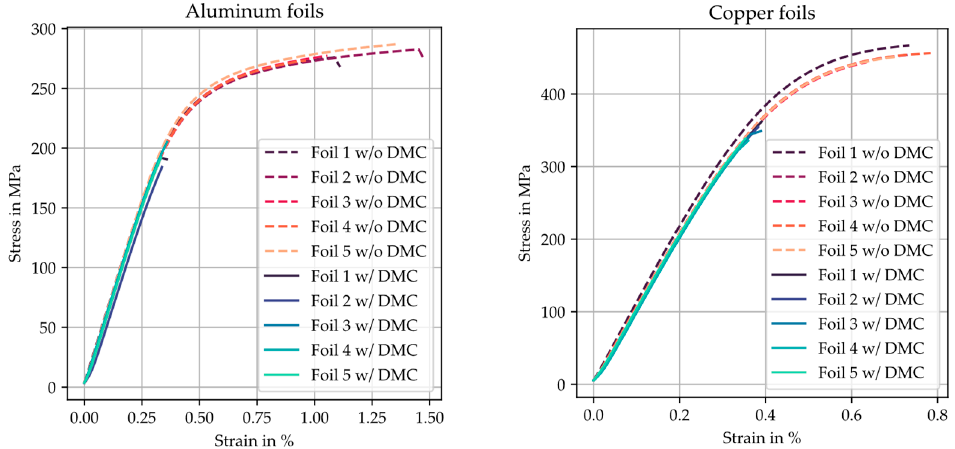
Figure 11. Results of the tensile test with laser DMC marked and unmarked aluminum ( left ) and copper foils ( right ).